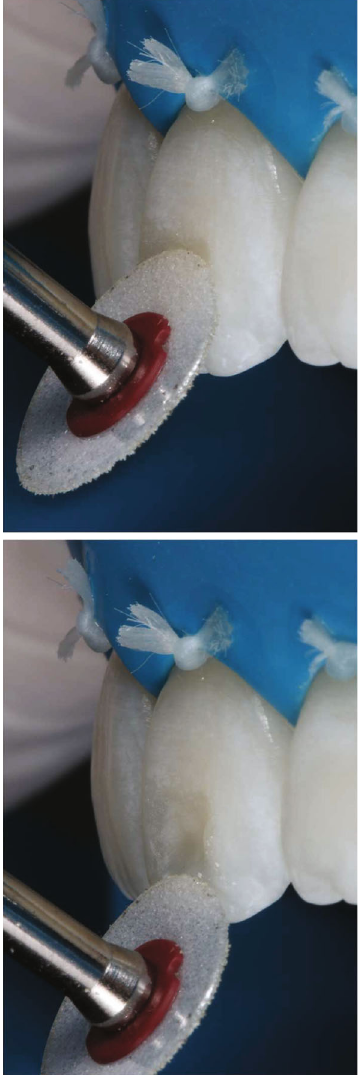
Figure 5: The fi nish of the bevel was made with coarse-grained sanding discs (OptiDisc, Kerr), thus eliminating fragile marginal